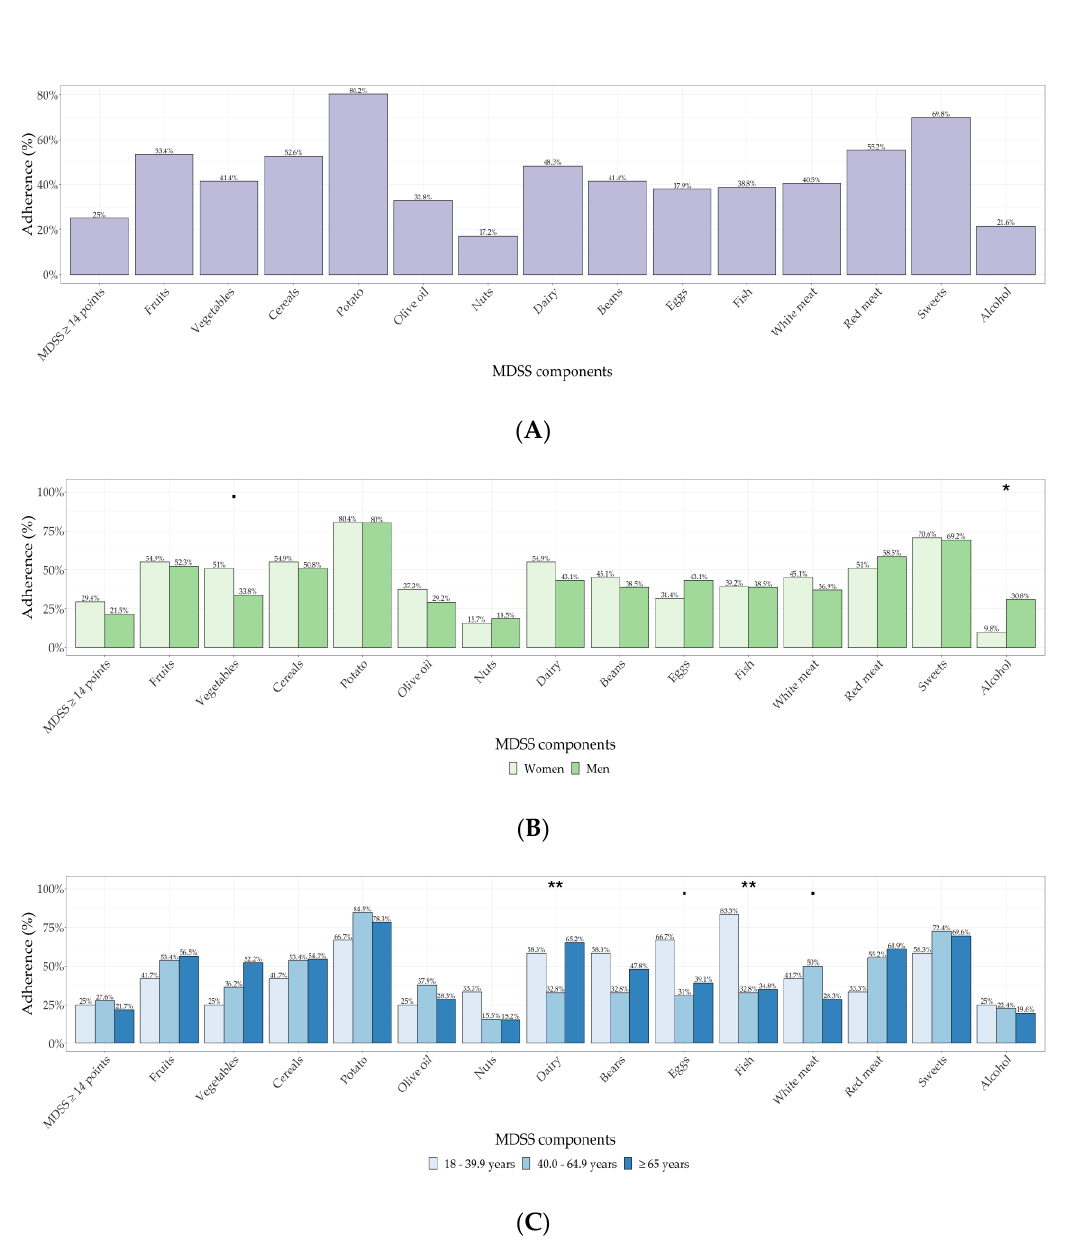
Figure 1. ( A ) Overall adherence to the MeDi and its components. ( B ) Sex differences in adherence to the MeDi. ( C ) MeDi adherence in different age groups of KTR patients. Abbreviations: MeDi—Mediterranean Diet, MDSS—Mediterranean Diet Serving Score, p -value < 0.1 depicted with dot, p -value < 0.05 depicted with *, p -value < 0.01 depicted with **.